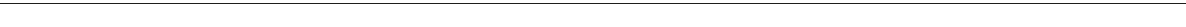
Fig. 5 Effects on spatial summation of inactivating feedback connections in a recurrent network model of V1. a The model architecture. Connection types are color coded according to legend. Pink and black boxes: population of layer 2/3 inhibitory (I) and excitatory (E) cells, respectively, labeled according to the position of their RFs relative to that of the cells in the center recorded V1 column; accordingly, E ctr /I ctr are the cells in the center column, and E near,far / I near,far those in the near and far surround, respectively. The proximal surround, as de fi ned in this study, encompasses the near surround (which is coextensive with the spatial spread of V1 horizontal connections) and the more proximal region of the far surround, while the distal surround encompasses the more distal region of the far surround (coextensive with the full extent of feedback connections). FF: excitatory feedforward afferents from other V1 layers to layers 2/3; E FB : excitatory feedback connections from a single extrastriate area to V1. Icons at the bottom and in panel ( c ); RF and surround components, with red areas indicating regions activated by a stimulus of increasing diameter. b Firing rate of the local E and I cells in the model, plotted against the input current. c Size tuning curves of the model E ctr and I ctr neurons with intact feedback and with different levels of feedback inactivation, as per legend. d – g Data-model comparison. Model results were computed by multiplying feedback weights by 0.5 (50% reduction in feedback activity). d Comparison of sRF size in the data (left) and in the model (right). e Normalized spike-rates measured at the peak of the size tuning curves with and without feedback inactivation, in the data (left) and in the model (right). Both the data and model responses were normalized to the response at the peak of the size tuning curve with feedback inactivated. f Suppression Index (SI) in the data (left) and model (right) for stimuli extending into the proximal surround, measured as described for Fig. 3b. g Normalized spike-rates with and without feedback inactivation measured at stimulus sizes corresponding to the peak of the size tuning curve with intact feedback. Both the data and model responses were normalized to. the response at the peak of the size tuning curve measured with intact